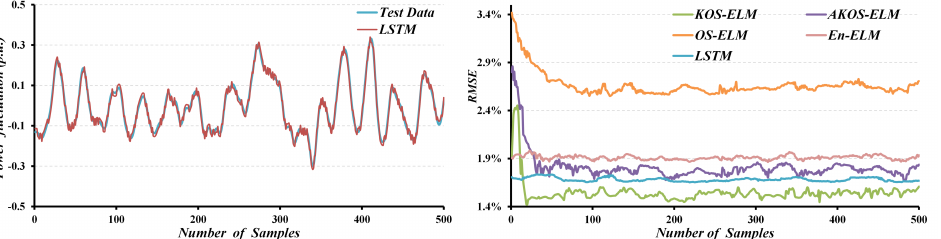
Figure 4. Prediction performance comparison of KOS-ELM, AKOS-ELM, OS-ELM, En-ELM, LSTM using Level-3 data set (part